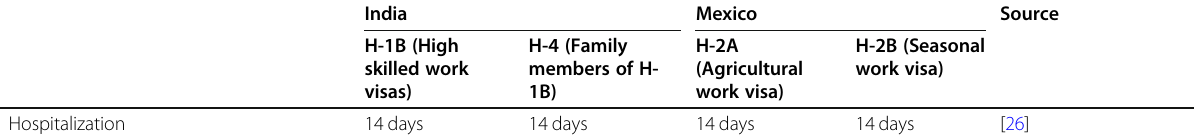
Table 1 Inputs to a model estimating costs of tuberculosis screening among Indian and Mexican nonimmigrant visa applicants, base case